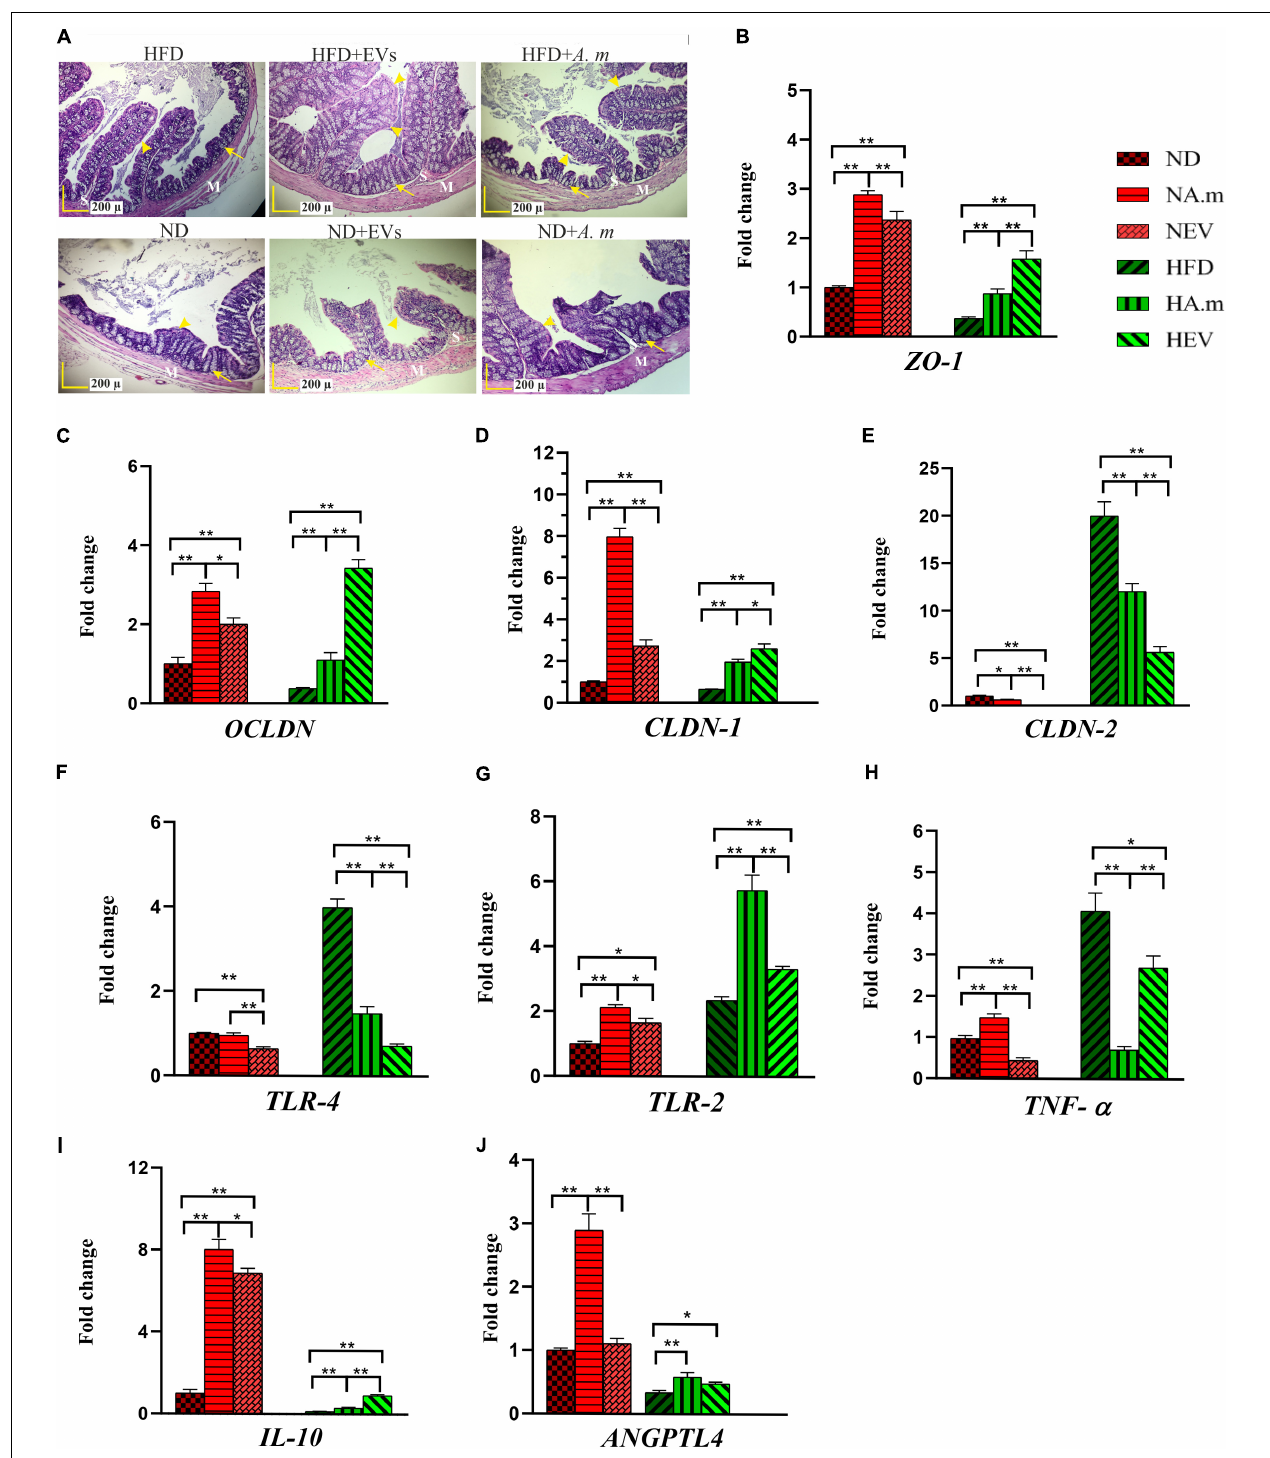
FIGURE 4 | The assessment of A. muciniphila and its EVs effect on obesity-related genes in the colon of HFD- and ND-fed mice. Both mice administrated to this bacterium and EVs for 5 weeks. (A) Histopathology image. M, tunica muscularis; S, submucosa layer. Crypt depth (arrows). Mucous thickness (arrowheads). Scale bar is 200 µ m. Expression of (B) ZO-1, (C) OCLDN, (D) CLDN-1 , (E) CLDN-2 , (F) TLR-4, (G) TLR-2 , (H) TNF- α , (I) IL-10 , and (J) ANGPTL4 . Data are normalized using RPL-19 as control gene. ∗ P < 0.05 and ∗∗ P < 0.01 were considered statistically significant, respectively. ND, normal diet + PBS; NA.m, normal diet + A. muciniphila (10 9 CFU); NEV, normal diet + EVs (10 µ g protein); HFD, high-fat diet + PBS; HA.m, high-fat diet + A. muciniphila (10 9 CFU); HEV, high fat-diet + EVs (10 µ g protein).